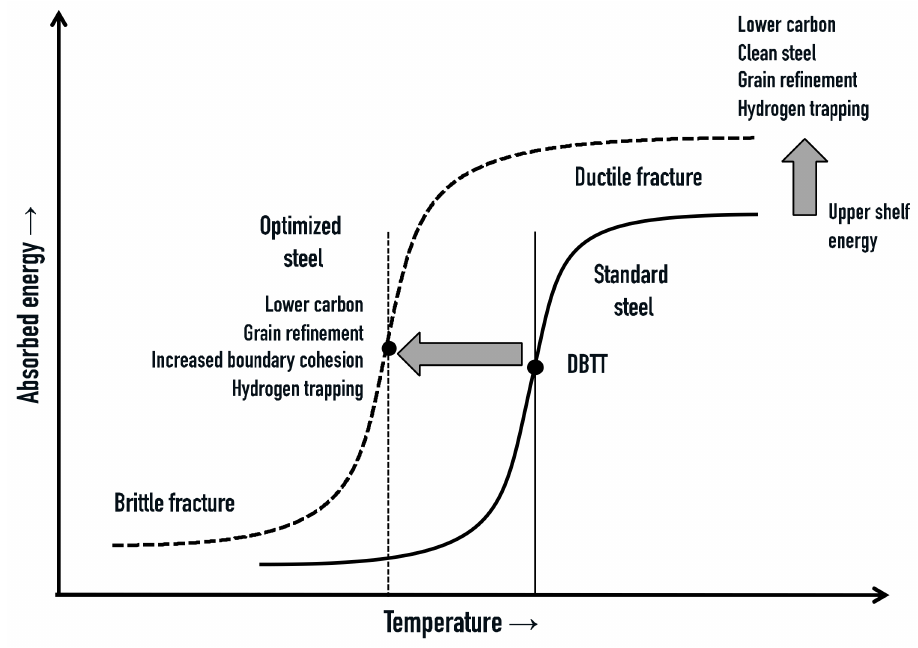
Figure 2. Strategies for optimizing the toughness characteristics of as-quenched martensitic